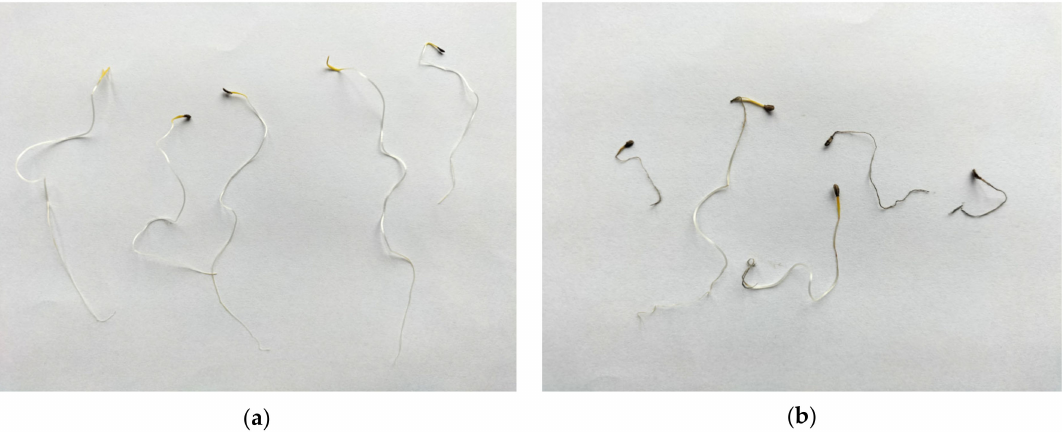
Figure 2. Normal seedlings ( a ) and abnormal diseased seedlings ( b ) after 14 days of